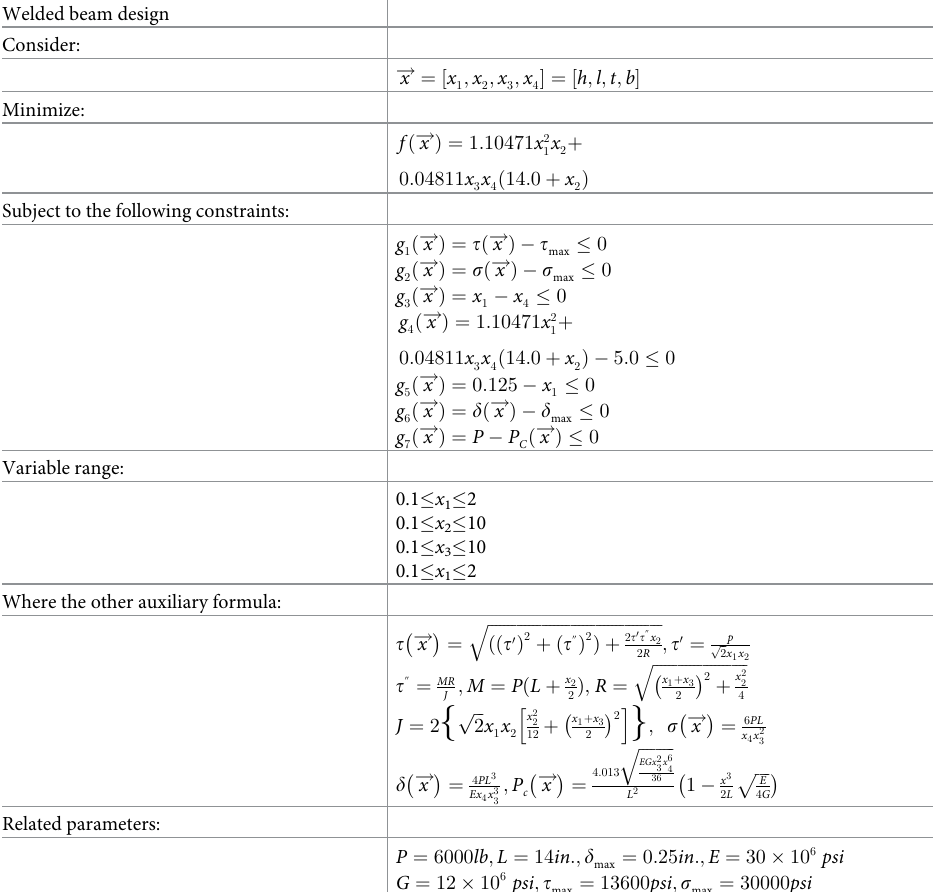
Table 7. Constraint condition of welded beam. Welded beam design